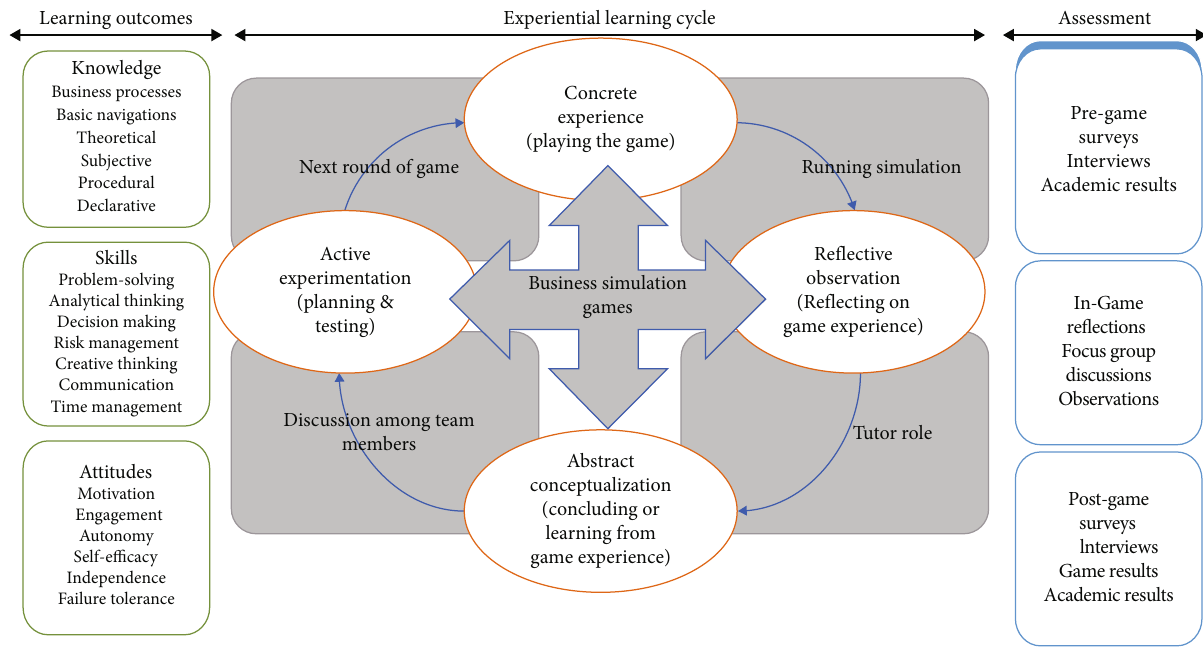
Figure 14: Overview of review fi